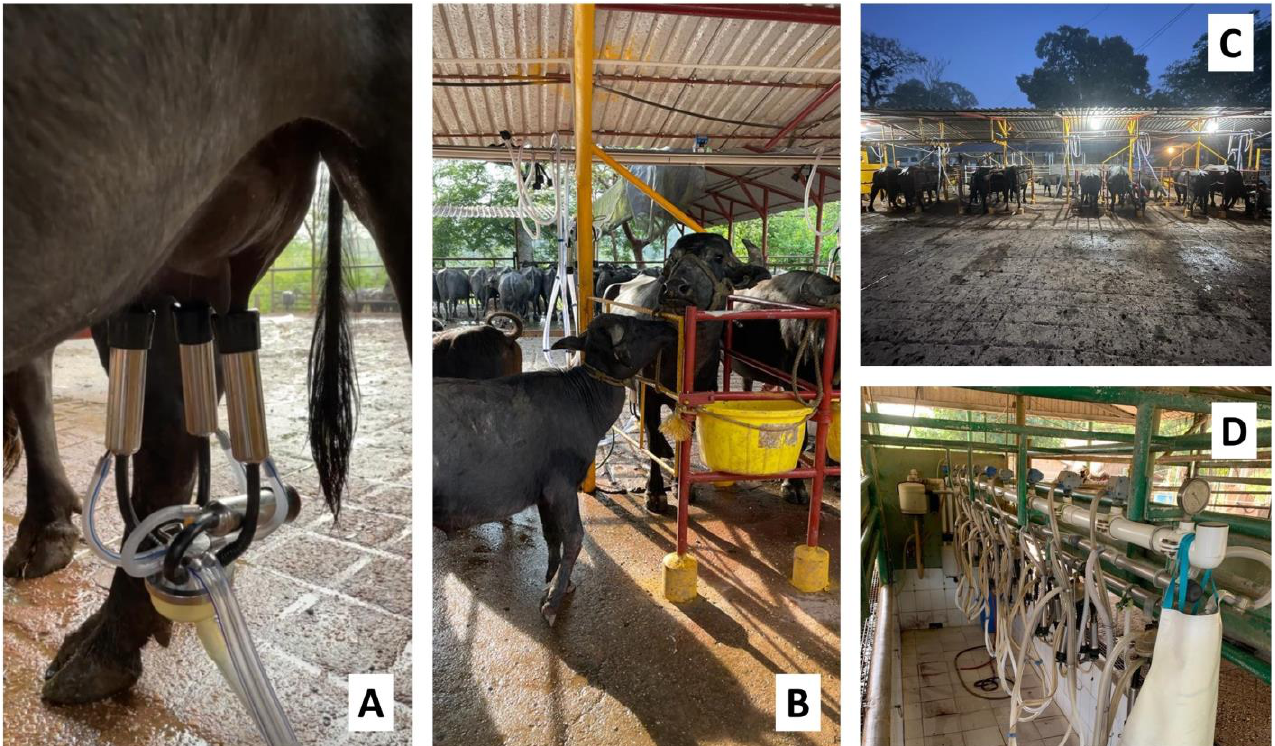
Figure 6. Mechanical milking in dairy buffaloes. ( A ) A mechanical milking station with a free liner for the standing calf serves as tactile stimulation for oxytocin secretion and milk ejection. ( B ) Mechanical milking station with standing calf support where tactile, auditory, and visual stimulation is allowed as well as feeders with ad libitum feed. ( C ) Adapted mechanical milking with space for breeding for the support and stimulation of milk ejection. ( D ) Mechanical milking parlor adapted to the characteristics of the water buffalo with the presence of feeders and without specific space for